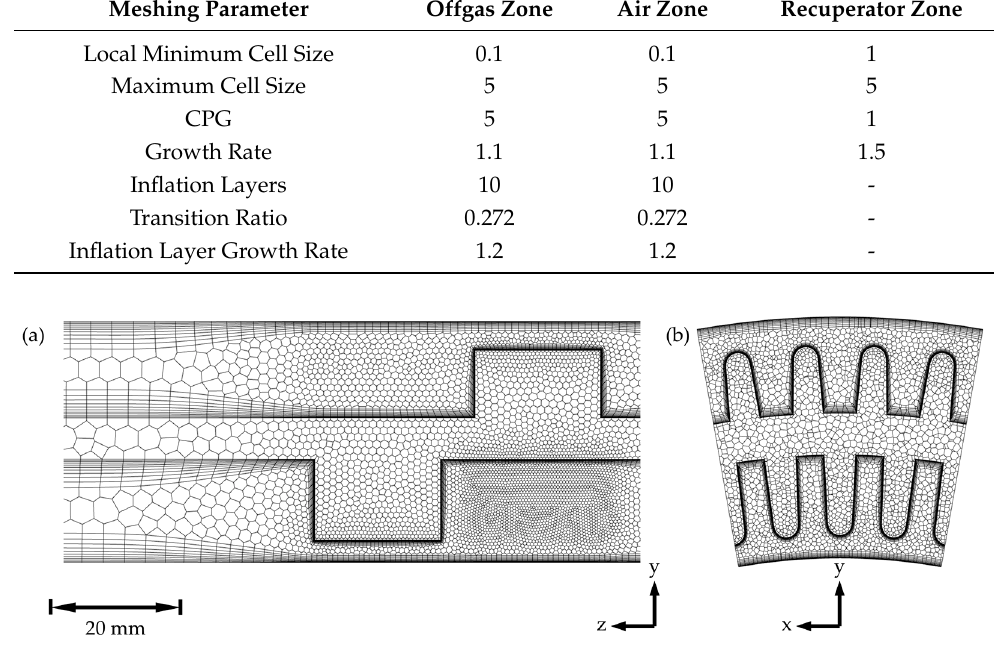
Figure 7. Mesh resolution in an axial cross-section ( a ) and radial cross-section ( b ).